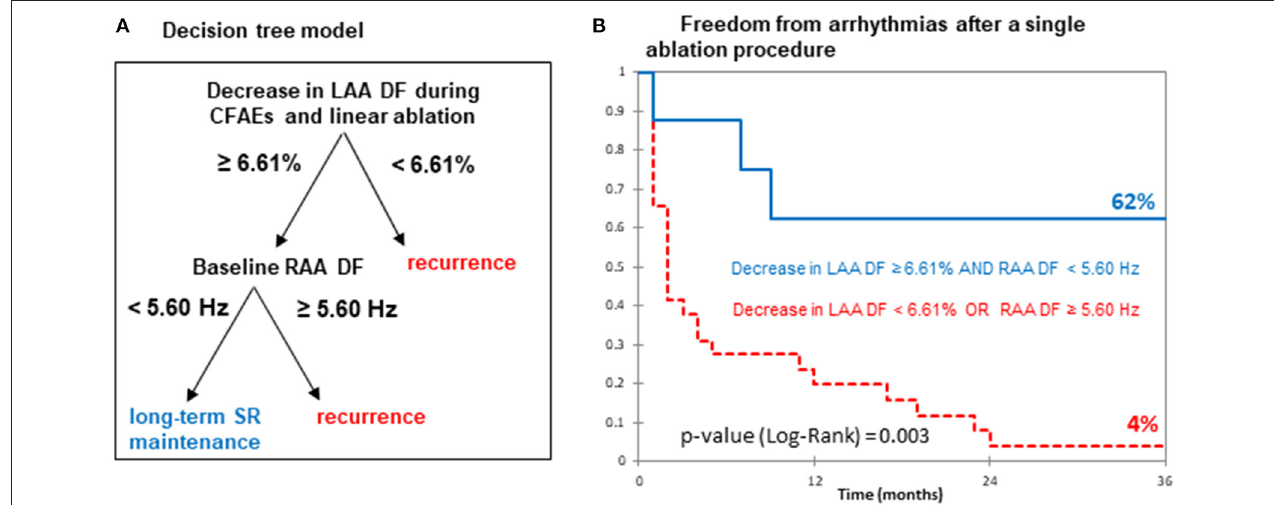
FIGURE 5 | Predictive performance of DF for long-term SR maintenance. (A) Decision tree model based on the relative changes in LAA DF after the first 20min of LA ablation and baseline RAA DF. (B) Kaplan–Meier curves for freedom from AF recurrence after catheter ablation. Abbreviations as in previous